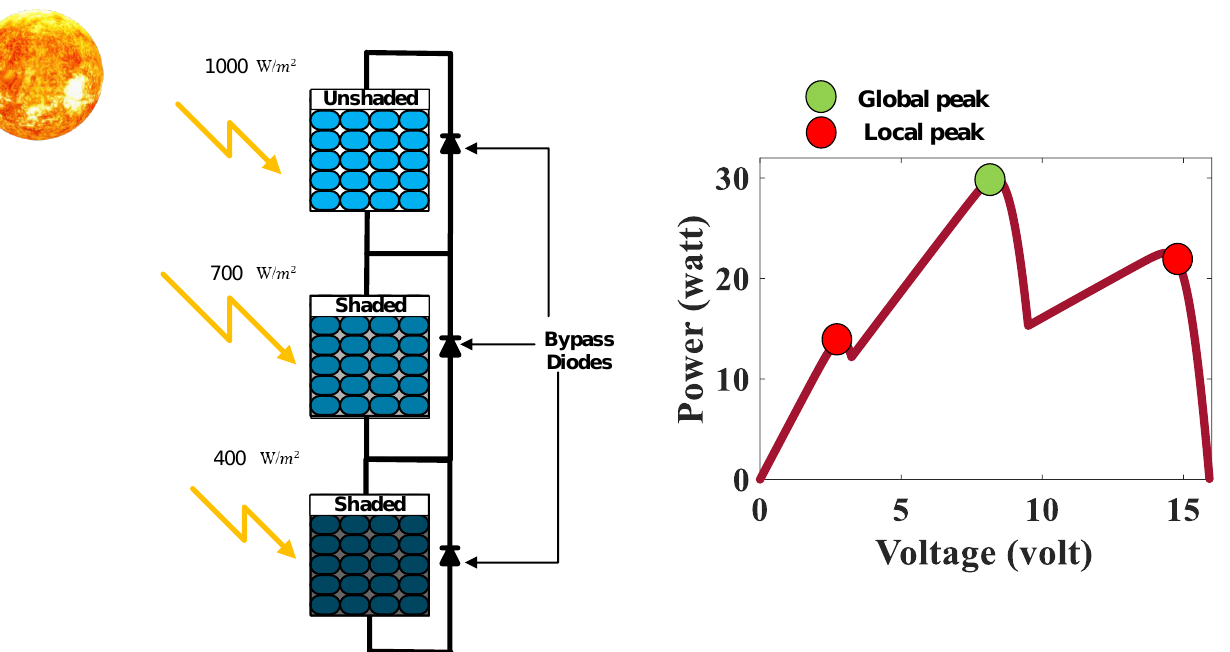
Figure 1. Partial shading mitigation using the bypass diodes. The green dot corresponds to the Maximum Power Point (MPP), while the red dots correspond to the Local Maximum Power Points (LMPPs).